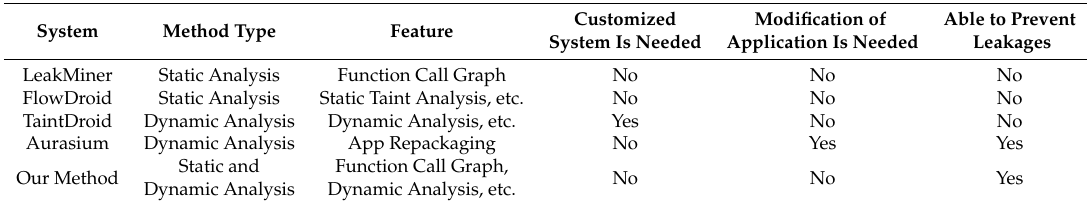
Table 5. Comparison with other